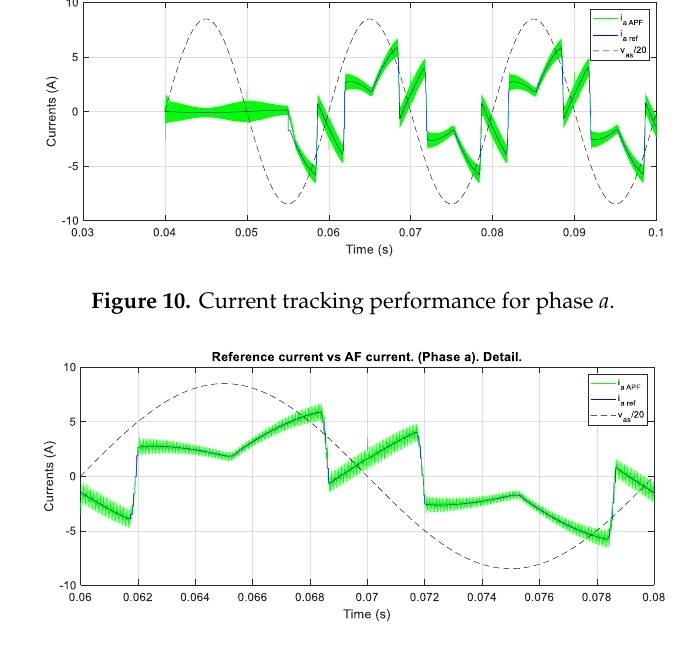
Figure 11. Current tracking performance for phase a . Detail 1 (0.06 s < t < 0.08 s).